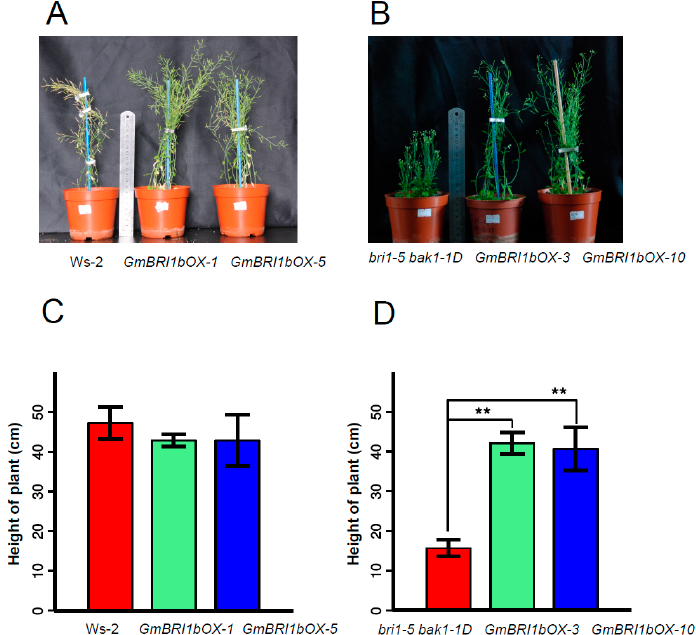
Figure 3. Over-expression of GmBRI1b increased plant height in the bri1-5 bak1-1D mutant. The height of 50-day-old Ws-2 wild type and two corresponding GmBRI1b over-expression lines ( GmBRI1b-OX ) ( A , C ); and the bri1-5 bak1-1D mutant and corresponding GmBRI1b-OX lines ( B , D ). Results are means ± SD from five plants. Experiments were repeated two times with similar trend (Student’s t -test, ** p <